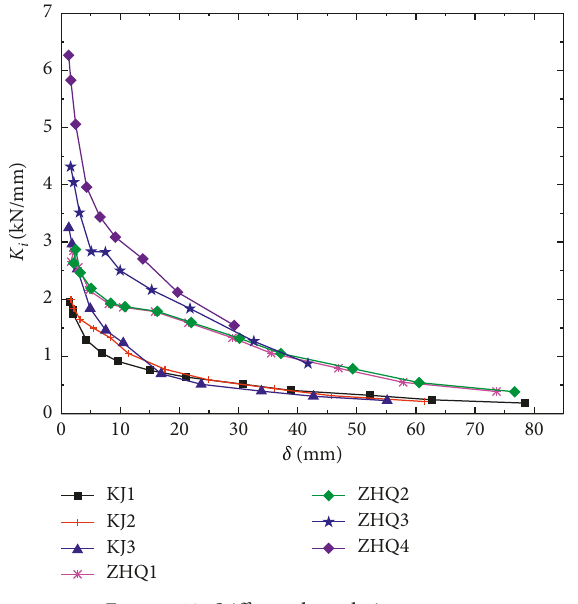
Figure 18: Stiffness degradation